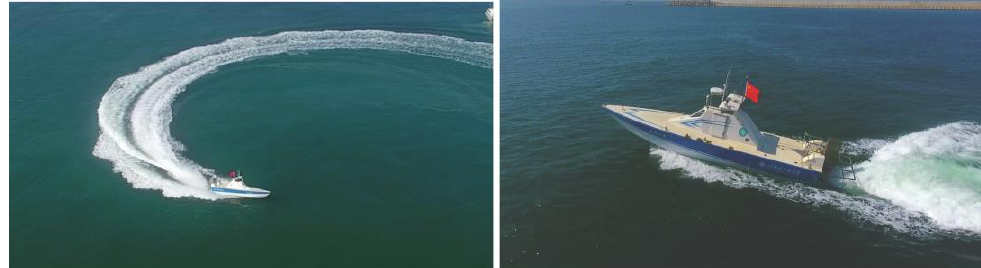
Figure 1. Unmanned surface vehicle named “ Tianxing-1 ” .